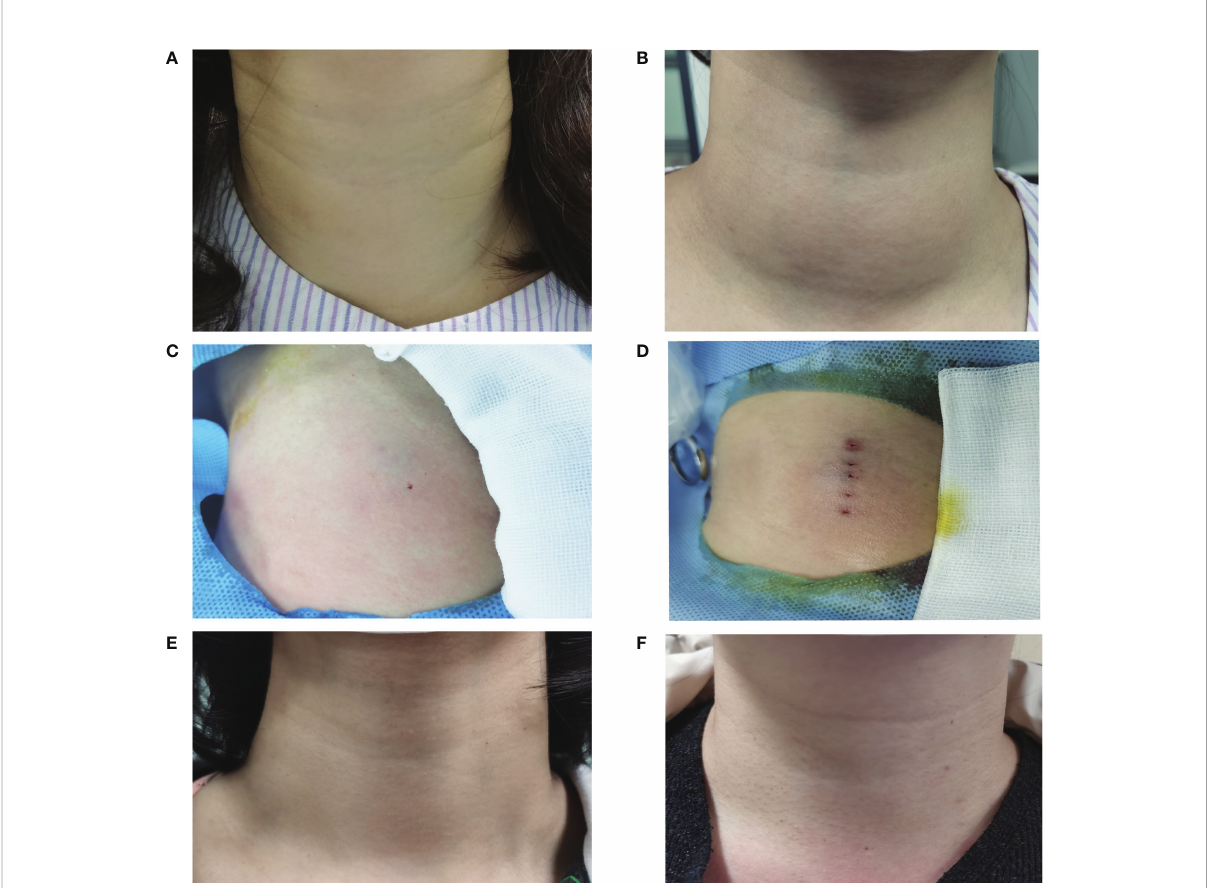
FIGURE 6 Comparison of the appearance of neck complaint using different needle placement strategies pre-procedure, on the procedure and at 12- month follow-up. The appearance of the fan-shaped overlapping and the parallel overlapping mode had a cosmetic score of 3 (A) and 4 (B) pre-procedure. The appearance of the fan-shaped overlapping mode and the parallel overlapping mode had one insertion point (C) and multiple insertion points (D) on the procedure. The symptom score and cosmetic score were signi fi cantly improved after RFA procedure. The patients both had a good cosmetic score without signi fi cant scars at 12 months after ablation using the fan-shaped overlapping mode (E) or the parallel overlapping mode (F) .